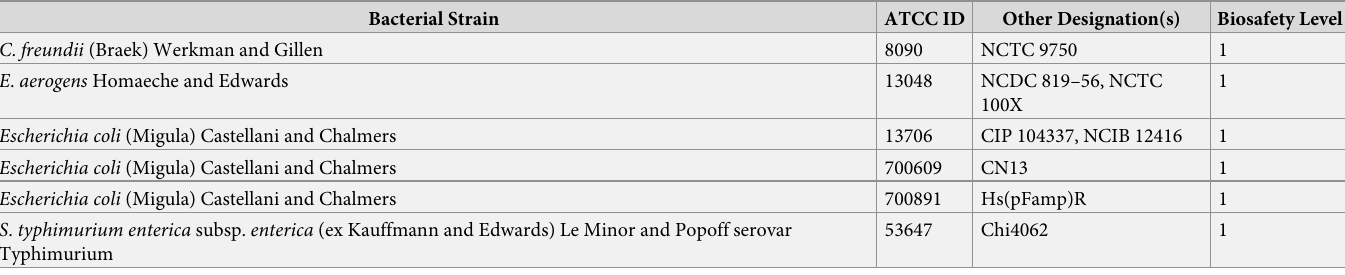
Table 4. Bacterial strains utilized in this